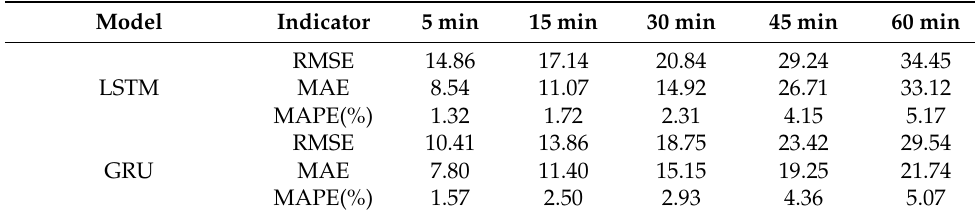
Table 2. Comparison of operating results.